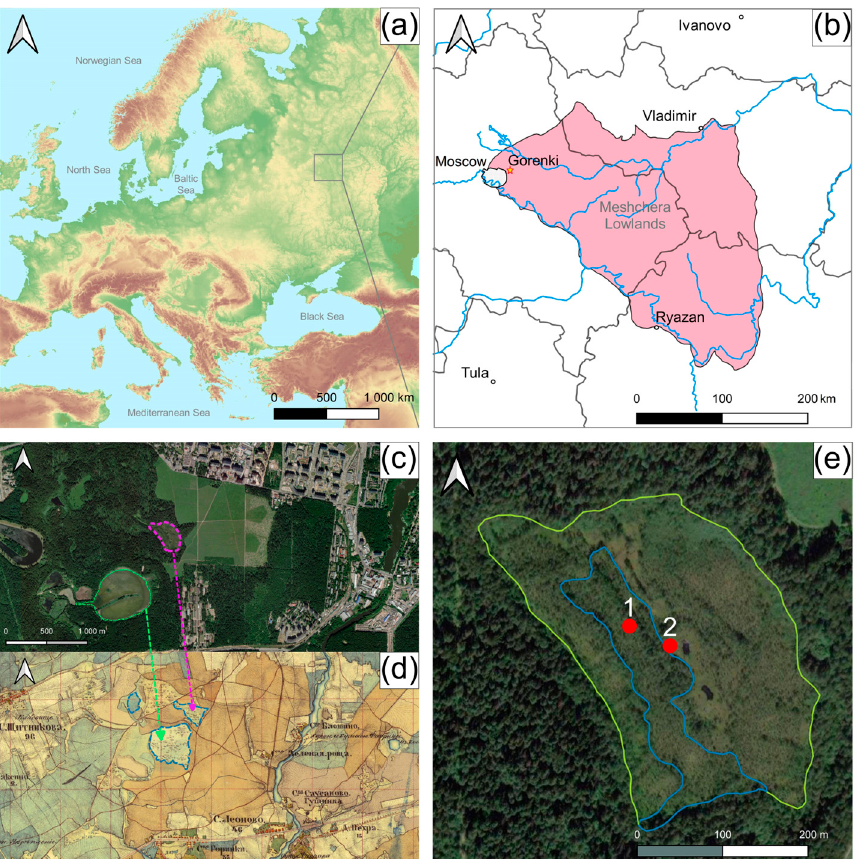
Figure 1. Map of the study region ( a ) with the location of the Gorenki mire within the territory of the Meshchera Lowlands (marked by a star) ( b ) and within the Gorensky Forest Park (pink dotted line marks the Gorenki mire, green dotted line marks Mazurinskoe lake) ( c ). The historical map ( d ) of the study site in 1838 CE (pink arrow indicates Gorenki mire before peat extraction; green arrow indicates Mazurinskoe mire before peat extraction). The map of the Gorenki mire ( e ) with the location of coring sites (1—the part una ff ected by peat extraction, 2— fl oating mat recovering after peat extraction; the yellow line is an outline of the peatland, the blue line is an outline of the undisturbed deposits).